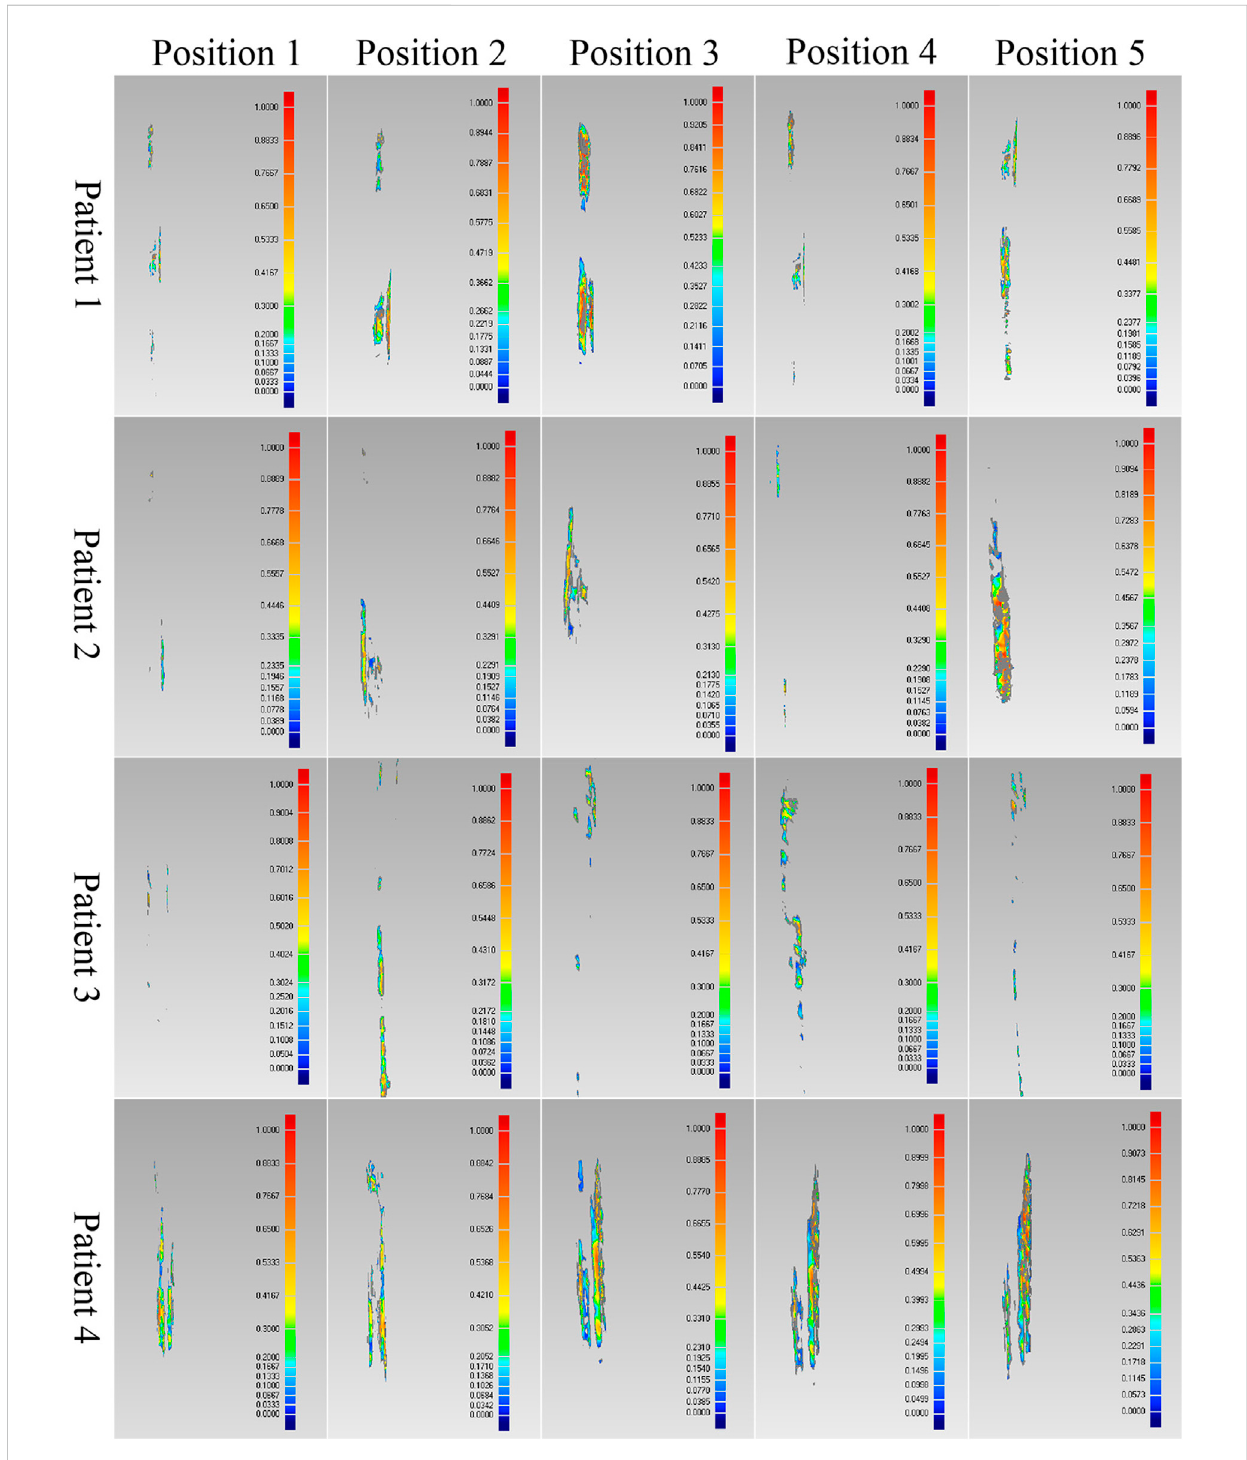
FIGURE 9 Comparison results of the optimal positions of four